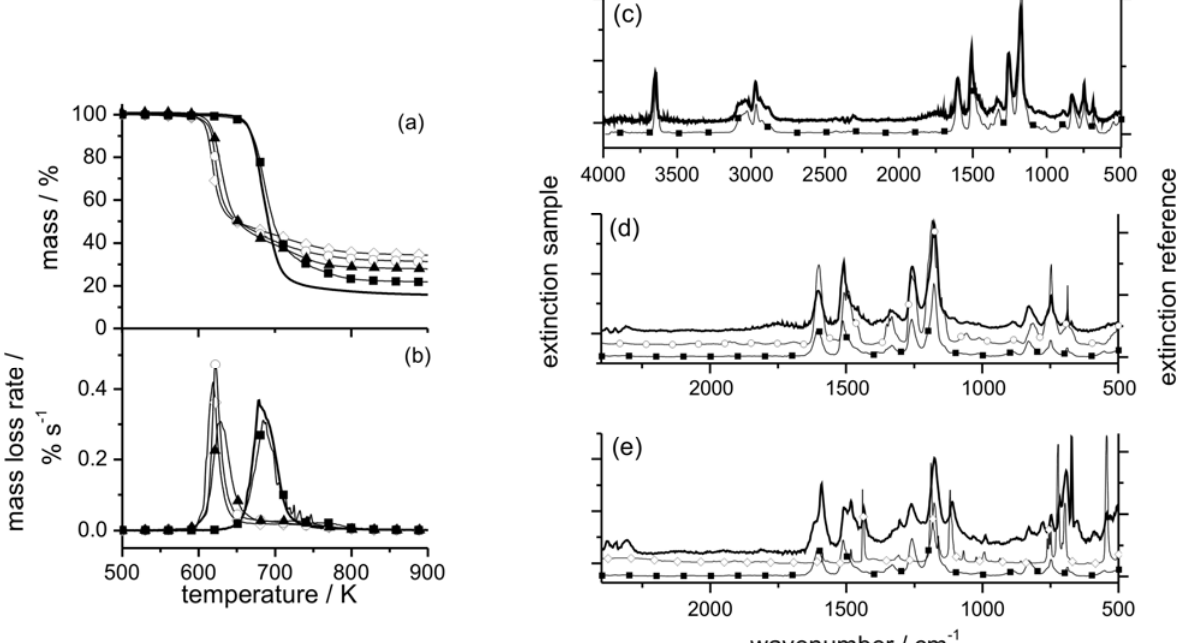
Figure 5. Mass (a) and mass loss rate (b) of EP (thick solid line), EP/PO (filled squares), EP/PO2 (filled triangles), EP/PO3 (open circles), and EP/PO4 (open rhombi) during thermal decomposition (heating rate = 10 K min –1 ). Characteristic evolved gas FTIR spectra (thick solid line) of EP/PO at 40 min (c, d) and 48 min (e) with reference spectra from a database (filled squares = bisphenol A, open circles = phenol, open rhombi = triphenylphosphine oxide). Remaining bands ~1745 cm –1 (c, d) are attributed to carbonyl compounds, and at 673 cm –1 (e) to